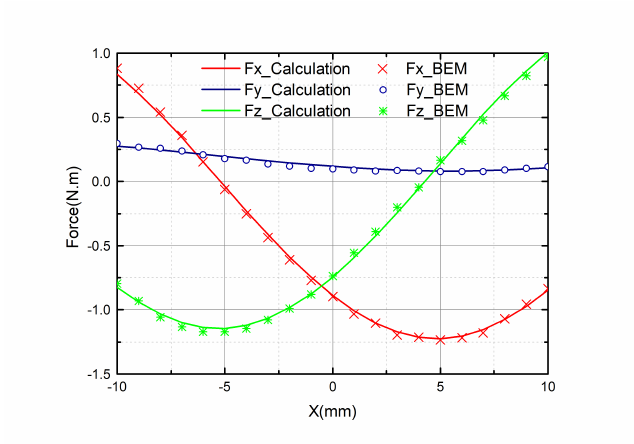
Figure 8. BEM and calculation results, c x p ∈ [ − 10 mm, 10 mm ] , c z p = 13 mm, and γ = 5 ◦ .